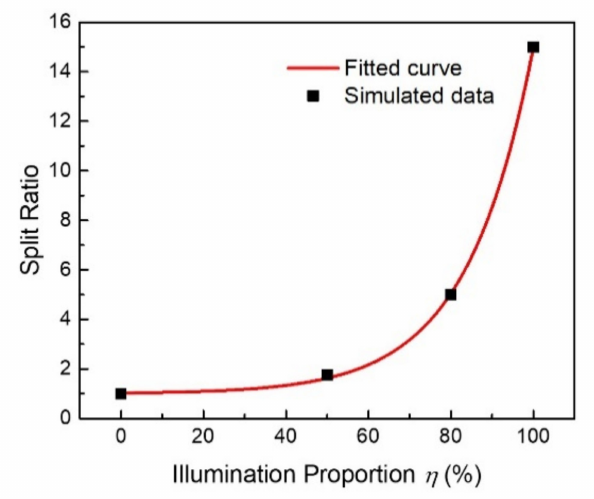
Figure 5. Relationship between the beam split ratio and the illumination proportion of supercell